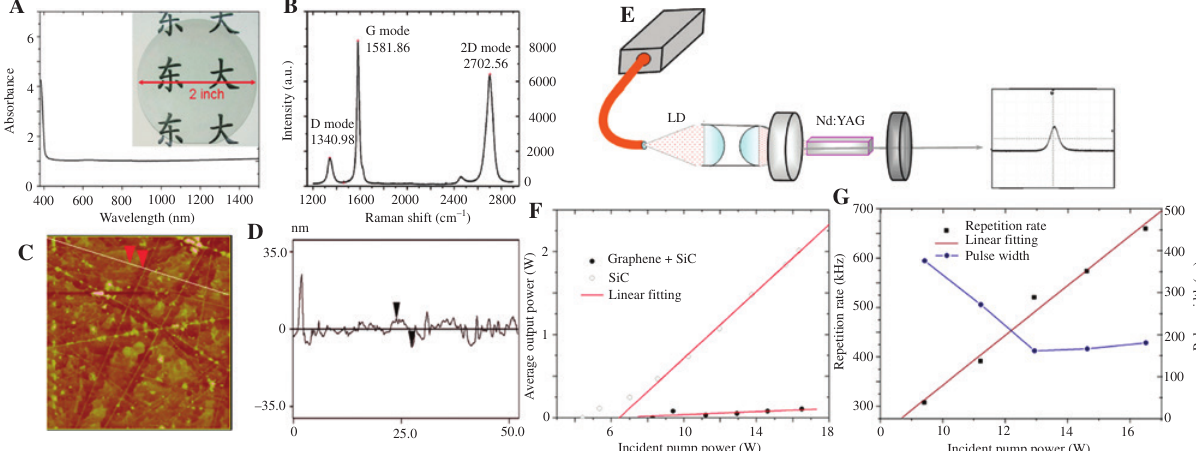
Figure 14: Performance of the first graphene Q-switched near-infrared laser. (A) Absorbance of graphene SA. Inset shows its photograph; (B) Raman spectra of graphene SA; (C) AFM image of the graphene SA; (D) typical height variation of graphene. (E) Experimental setup of graphene Q-switched Nd:YAG pulsed lasers. (F) The output power varies with the incident pump power. (G) Repetition rate and pulse width via the increase of incident pump power. Reproduced with permission [274]. Copyright 2010, American Chemical